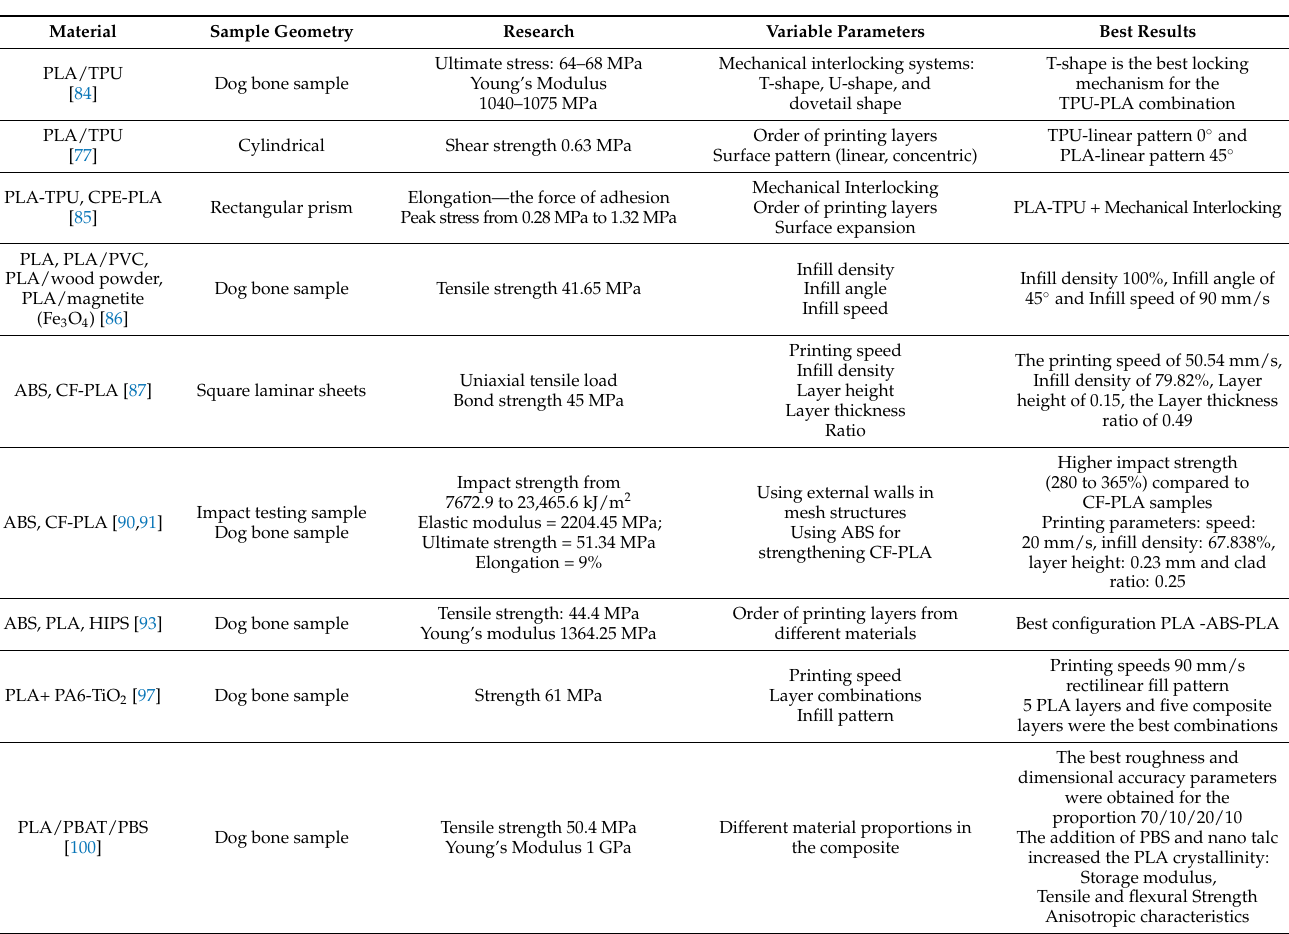
Table 1. Summary of information on layered printing for selected